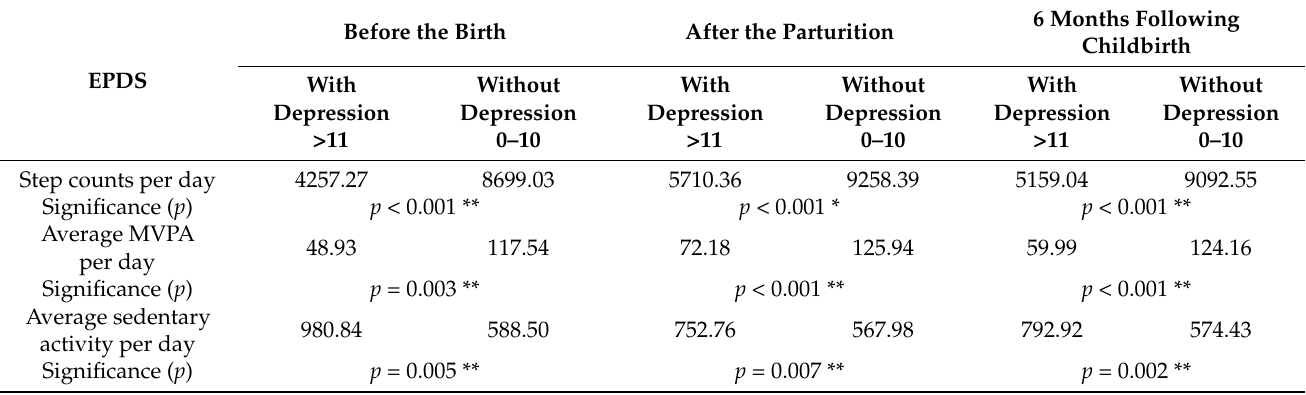
Table 3. The relationship between physical activity and the occurrence of